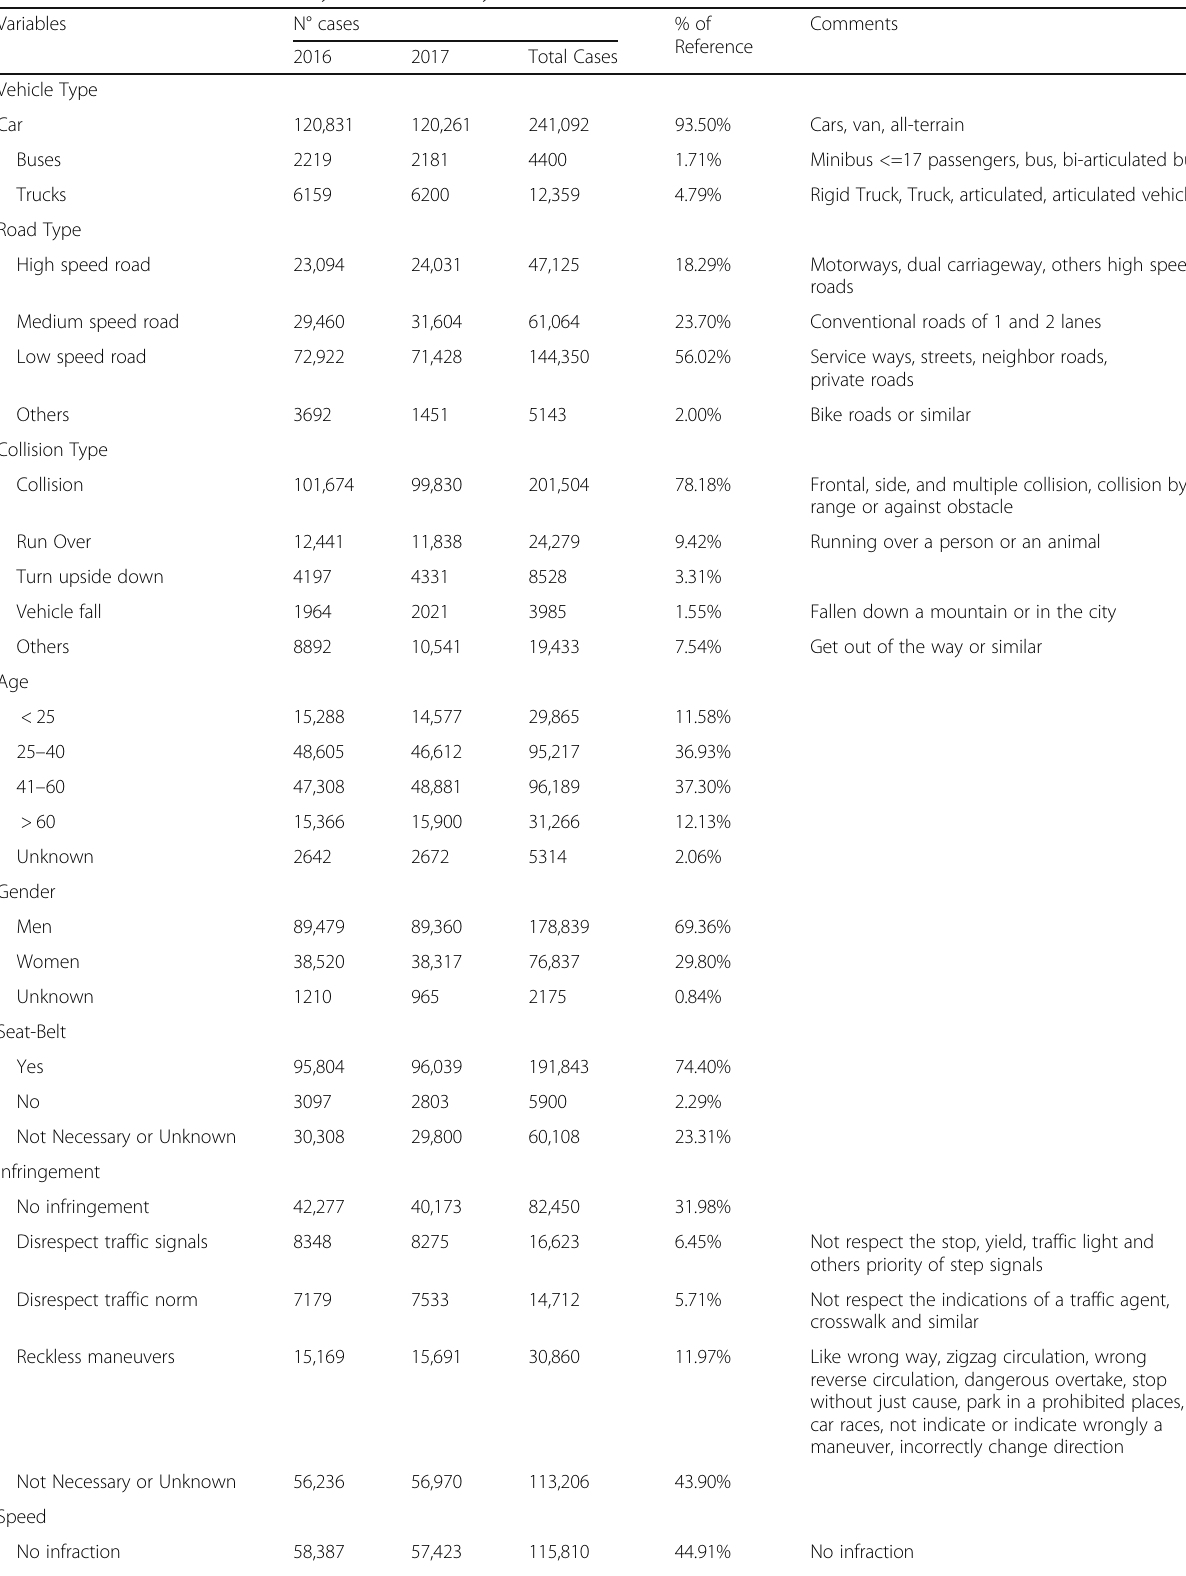
Table 1 Total number of cases analyzed. Processed by the